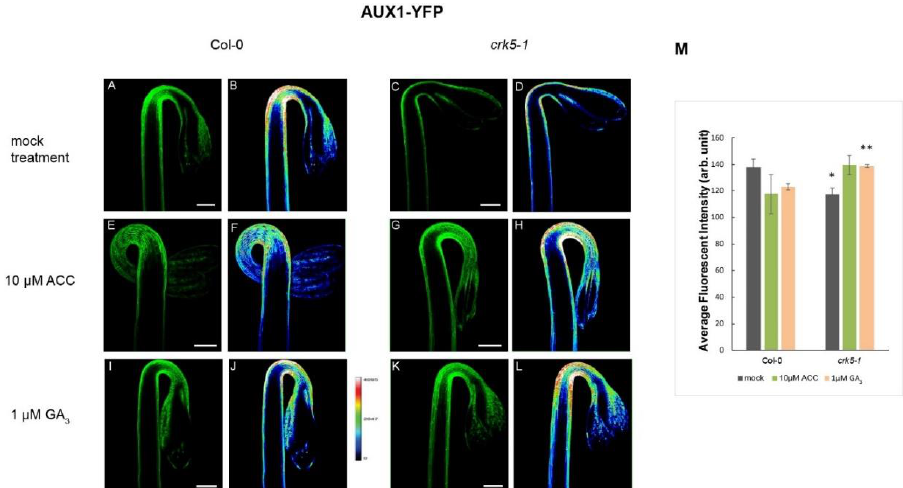
Figure 6. Distribution of the AUX1-YFP signals in 3-days-old dark-grown Col-0 wild-type and At crk5-1 mutant seedlings. Abundance of the AUX1-YFP signal in the hypocotyl hook of Col-0 wild type ( A , B ) and the mutant At crk5-1 ( C , D ). There is significantly lower YFP signal in the mutant hook ( C , D ) than in that of the wild type ( A , B ). Upon ACC treatment, the YFP signal became extended in both categories ( E , F and G , H ) and intensified in the mutant hook ( G , H ). GA 3 treatment broadened the AUX1-YFP signal area at the apical hook of the wild type ( I , J ) and mutant ( K , L ) and elevated the mutant YFP signal intensity to the wild type level ( K , L ). ( M ) Relative intensity of the AUX1::YFP signals in hypocotyl hooks. Asterisks indicate significant differences, comparing the mutant to the corresponding Col- 0 control (Student’s t- test, * P < 0.05 and ** P < 0.001, n = 10 seedlings per experiment). All experiments were repeated two times. Scale bars = 200 μm.